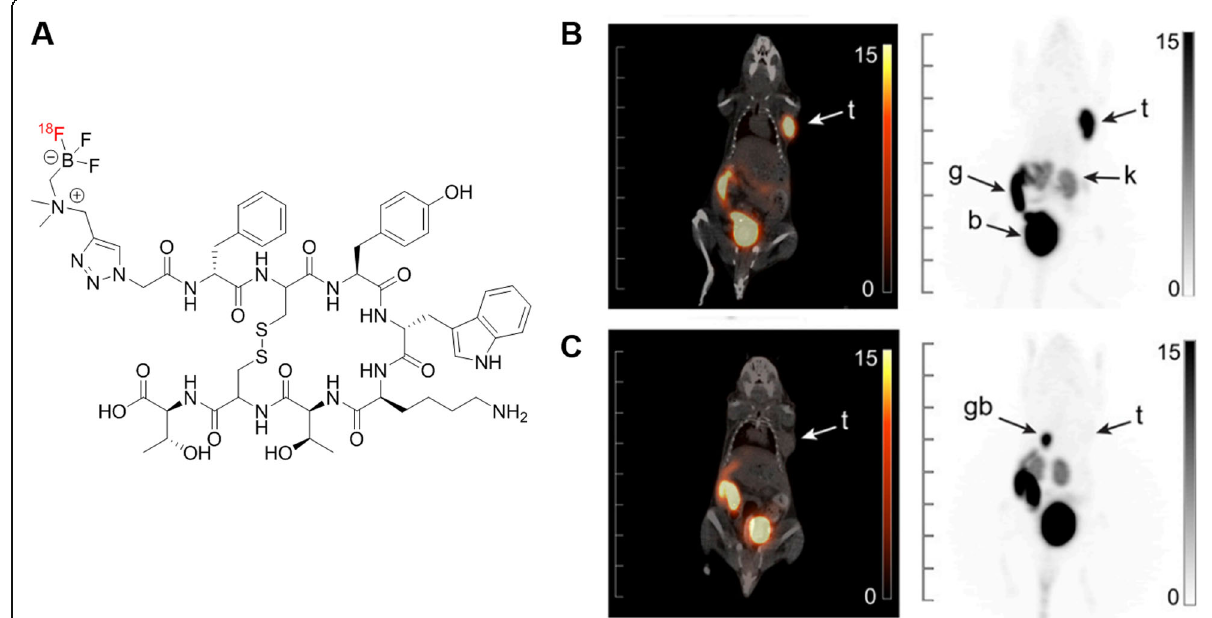
Fig. 1 a Chemical structure of [ 18 F]AmBF 3 -TATE. b Baseline PET/CT and PET maximum intensity projection image of [ 18 F]AmBF 3 -TATE acquired at 60-min post-injection in mice bearing AR42J exocrine pancreatic tumor and c with 15 min pre-injection of Ga-DOTA-TATE for blockade. t tumor, g gut, k kidney, b bladder, gb gallbladder. Figure adapted with permissions from Liu et al. Copyright 2014 Society of Nuclear Medicine and Molecular